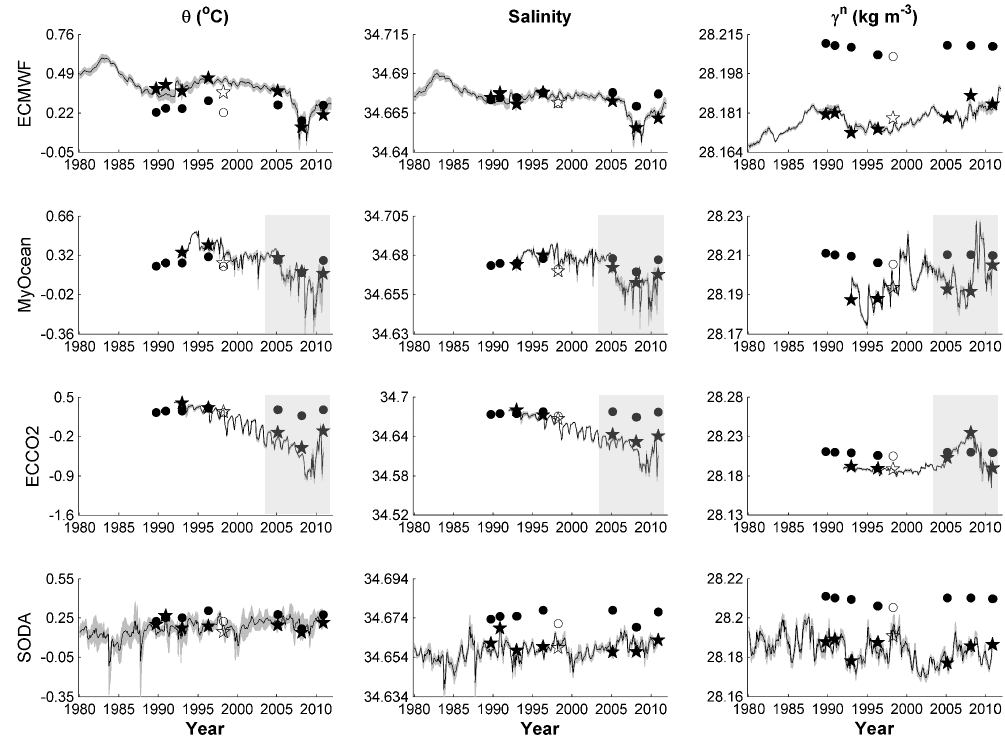
Figure 12. Time series of monthly mean hydrographic properties of WDW in ECMWF, MyOcean, ECCO2, and SODA (top to bottom) averaged along the WOCE SR4 section line. From left to right: θ , S , and γ n . The gray shading indicates the standard deviation due to variation caused by the different station locations in the different years of the hydrographic cruises (excluding the set of stations of 1998). The dots indicate the values derived from the observed data, and the pentagrams are the values from the corresponding reanalysis data. The filled markers denote full sections, and the open markers denote section 1998, which does not extend over the entire eastern margin of the Weddell Sea. Note that the scales are different to show the variability in the time series. The gray rectangles denote the period in which the hydrographic properties showed anomalous